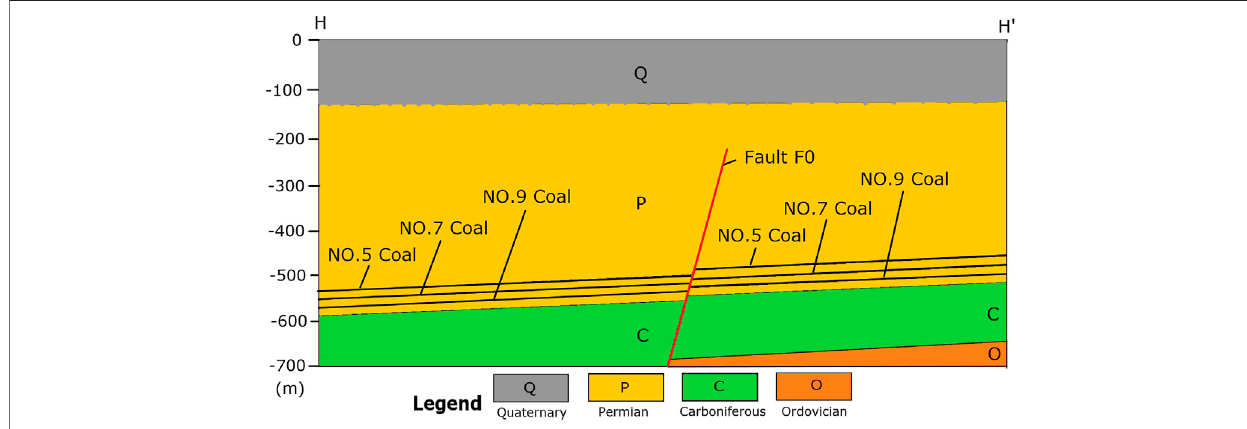
FIGURE 2 | Cross section view along H-H ’ (marked in Figure 1 ).